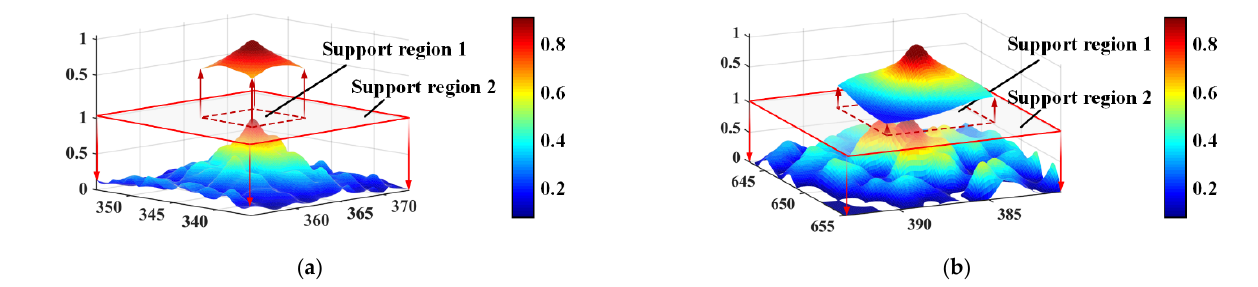
Figure 10. Comparison for the traditional weighting template and the guidance-aided adaptive weighting factor in the Frost filter: ( a ) is the comparison for the weight template in uniform region; ( b ) is the comparison for the weight template near the edge. The dotted squares represent the support regions of the traditional Frost filter, and the red squares are support regions of the proposed method.